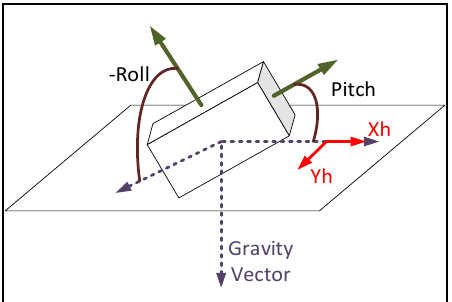
Figure 1. The gravity and magnetic vectors shown in N coordinate frame.